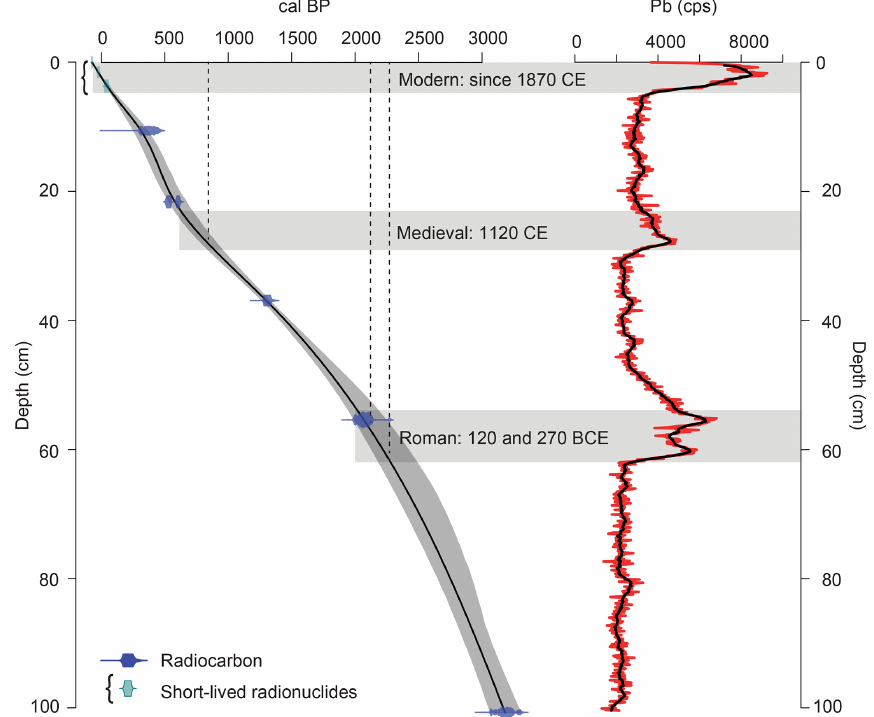
Figure 3. Age–depth model of the 102cm Lake Bastani sedimentary sequence (BAS13P4), including 210 Pb / 137 Cs chronology (Fig. S4) and 14 C ages (Table 1). Lead measurement in the lake sediments with the identification of three pollution peaks and associated